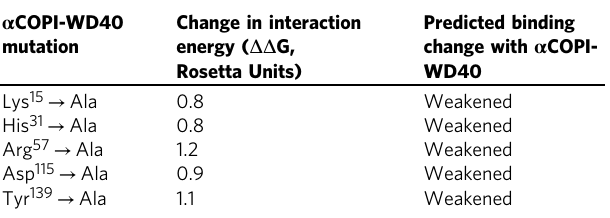
Table 4 Effects of in silico α COPI-WD40 mutagenesis on spike hepta-peptide